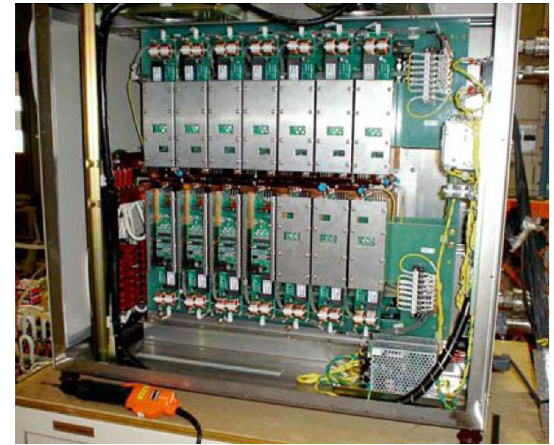
28. A photograph of the SPS. There are seven MOSFETs in each arm.